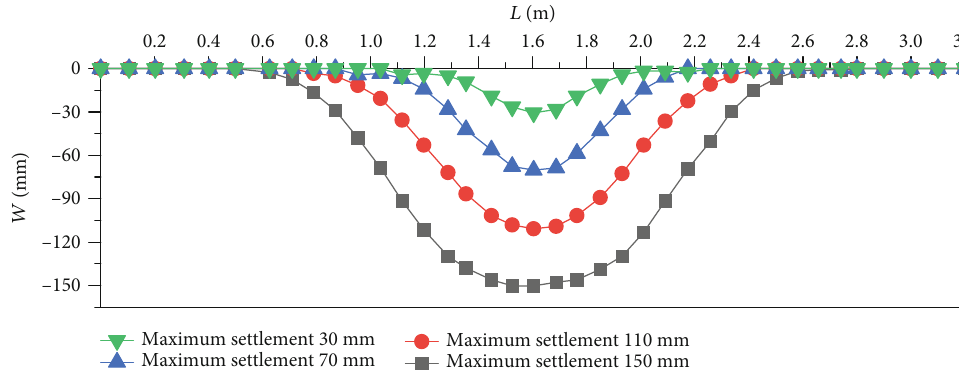
Figure 3: Test soil subsidence curve.